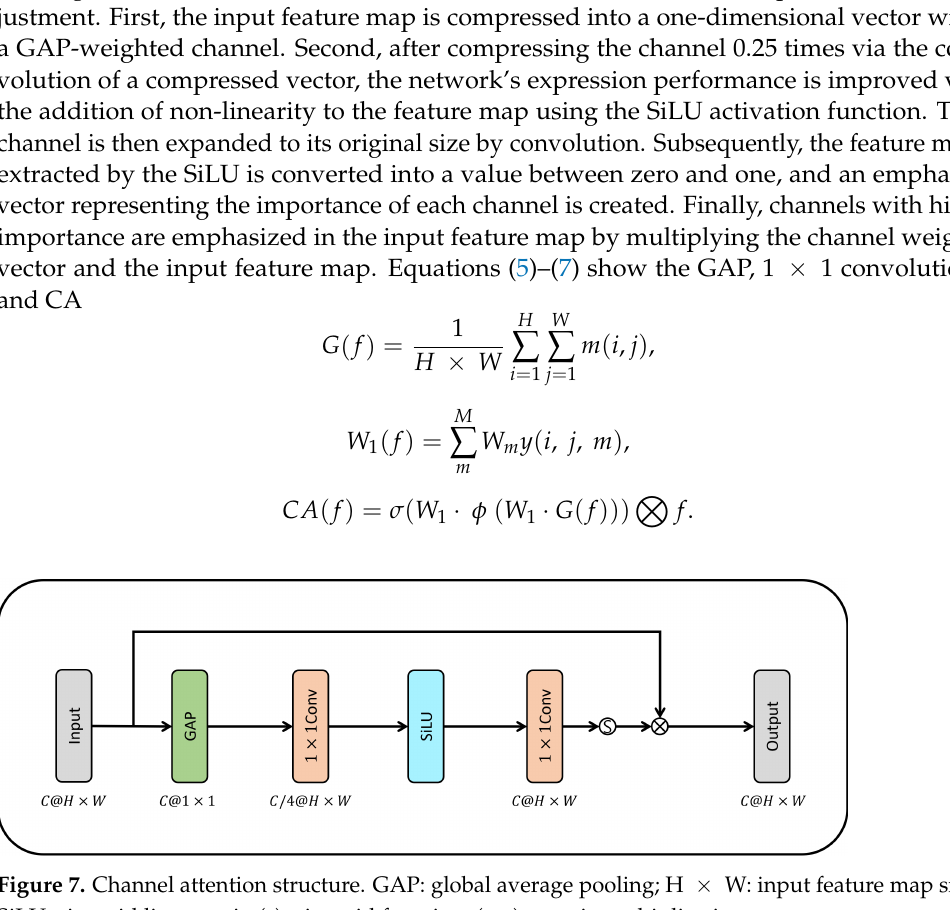
Figure 7. Channel attention structure. GAP: global average pooling; H × W: input feature map size; SiLU: sigmoid linear unit; (s): sigmoid function; ( × ): matrix